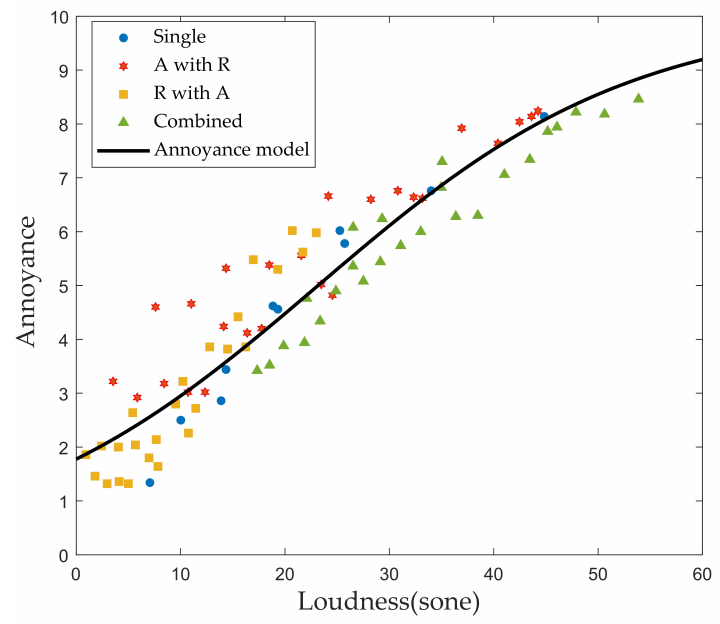
Figure 10. Short-term annoyance